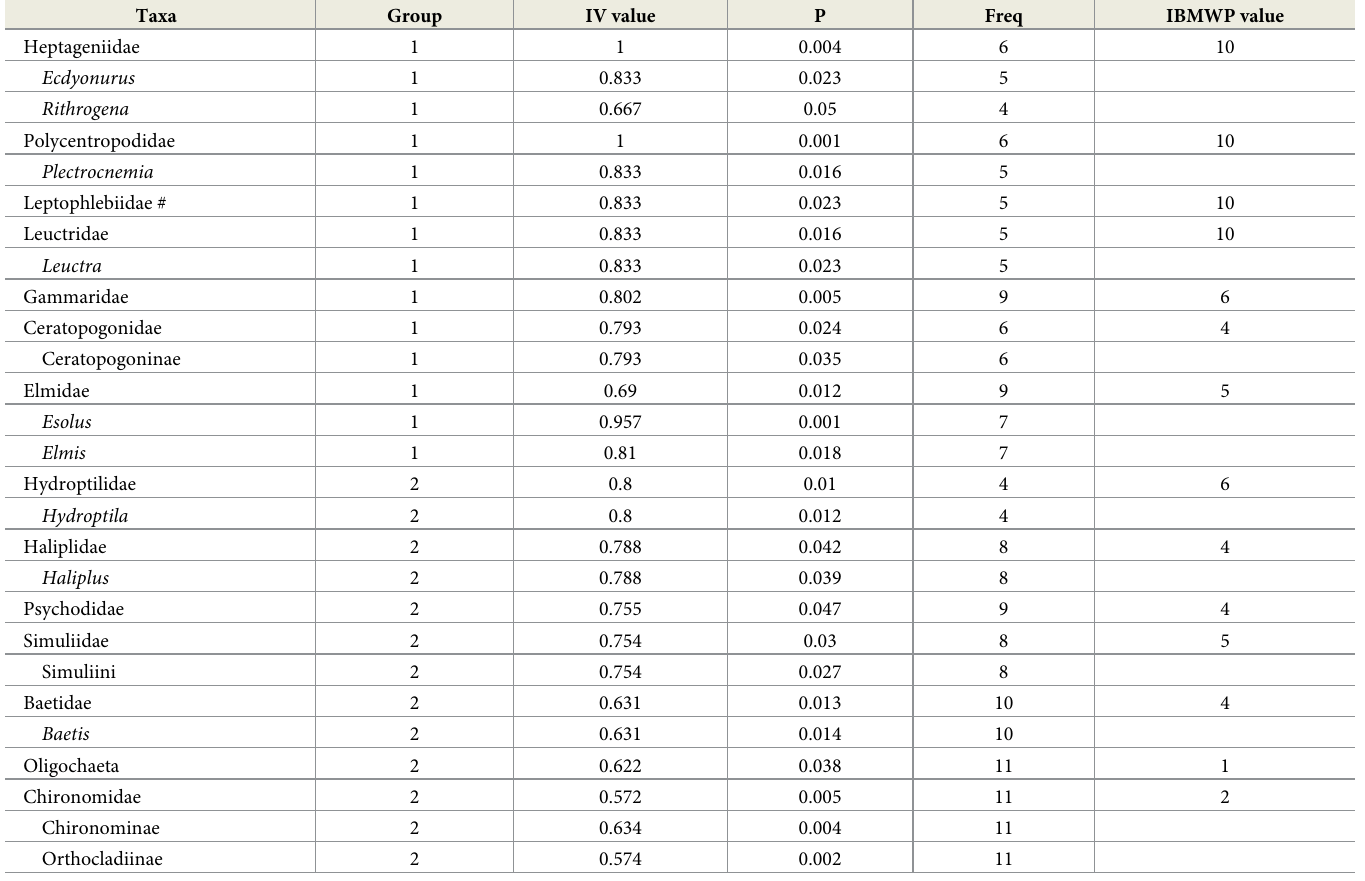
Table 2. IndVal analysis. IndVal analysis results showing taxa significantly associated with one of the previously established groups (Fig 2). For those taxa included in the IBMWP index, their score is shown. # means that the whole family was significantly associated with one of the groups, but no genus within the family